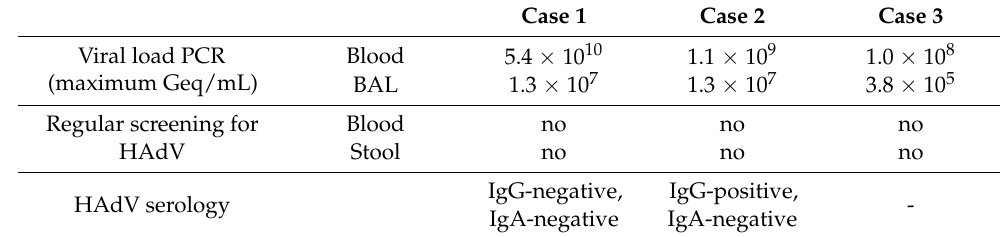
Table 4. Virological diagnostics.